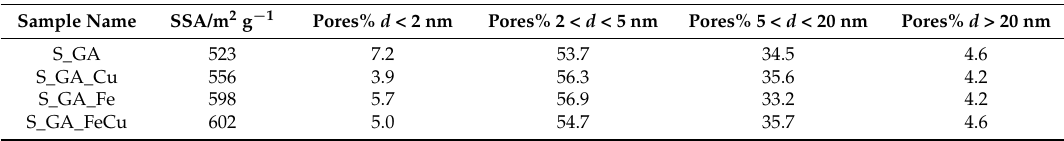
Table 1. Specific Surface Area (SSA) and Pore Area Distribution.